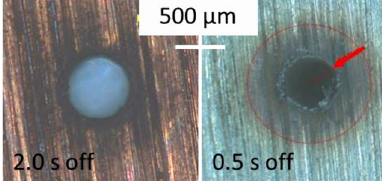
Fig. 9. Decreasing the break between the drilling intervals of 0.5s from 2.0s to 0.5s results in the appearance of dross on the surface of the sample, marked by the red arrow.